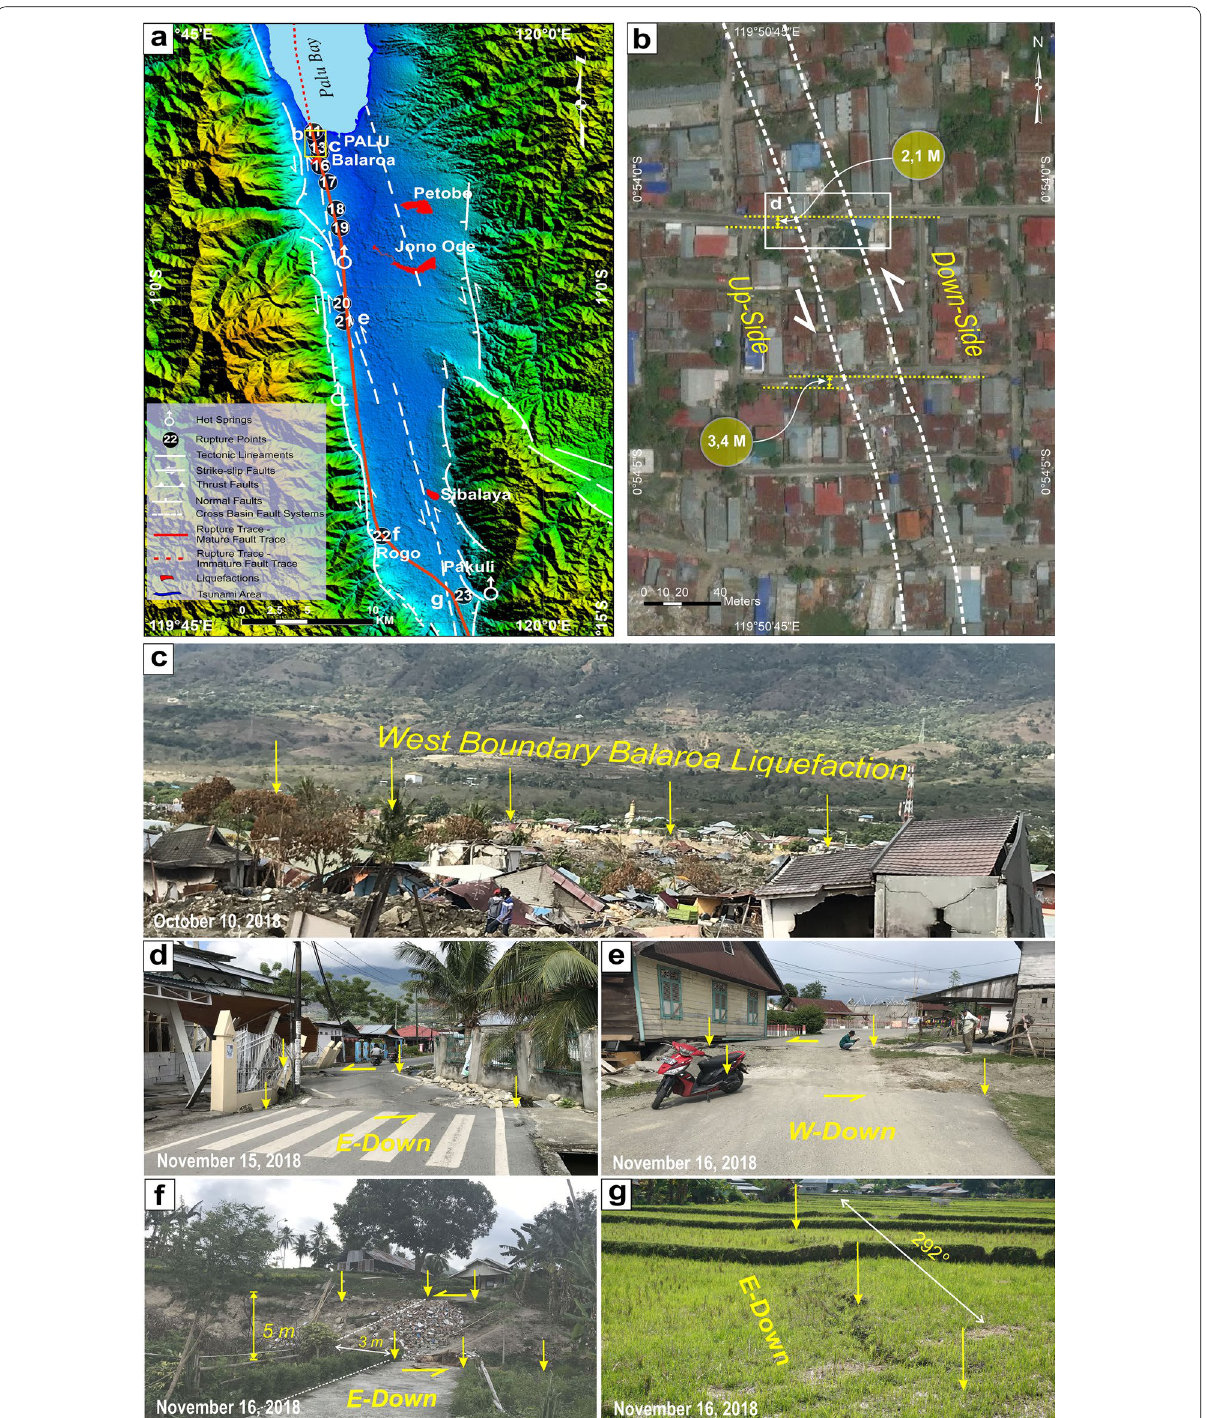
Fig. 4 a Site map of surface rupture, ground fissures, hot springs, and liquefaction areas in the Palu basin area. Structural lineaments are drawn after Watkinson and Hall (2017). The base map is a 30-m DEM-SRTM (USGS). b The rupture zone crossing the urban area of Palu city, in which constructions are seriously damaged. Abrupt bending of roads indicates a sinistral slip. (overlaid on Google Satellite imagery updated from 2018). c Liquefaction in the Balaroa area. d Surface rupture crossing Cemara I street in Palu city. e Surface rupture of Dolo Barat. f Surface rupture of Rogo village (5 m). g Surface rupture extending in a rice field in Pakuli